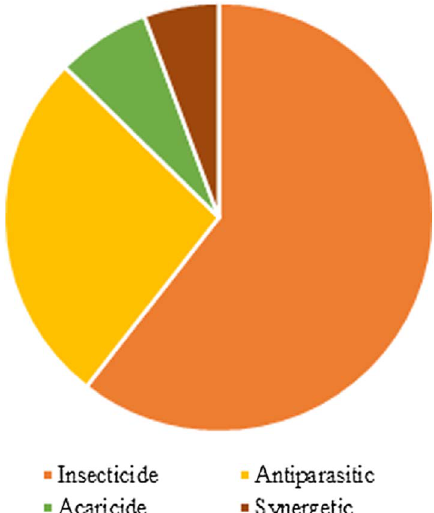
Figure 3. Distribution of the focus of the topics in the revised